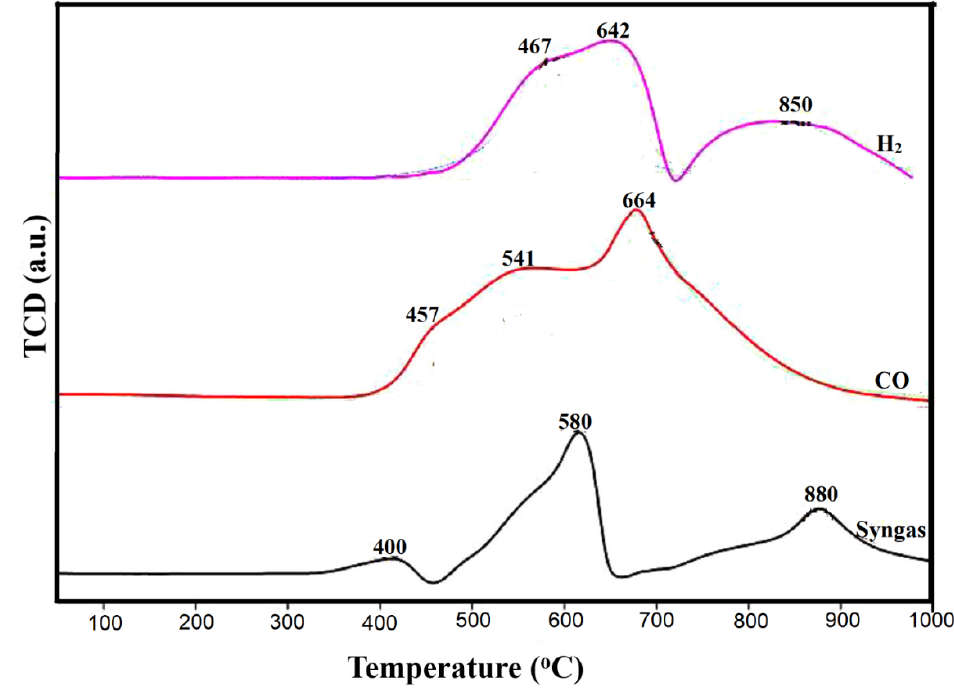
Figure 3. TPR profiles under varying reducing agents [2]. Reproduced with permission from Else- vier.